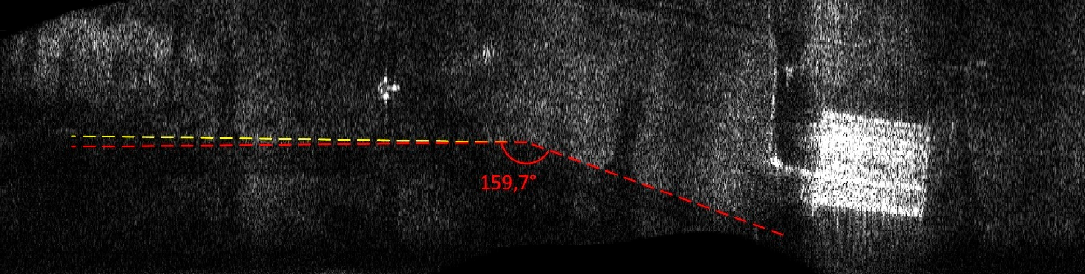
Figure 17. Radar terrain image obtained with the use of INS/GPS data; yellow line—a north edge of the taxiway determined using INS-based image, red line—a north edge of the taxiway determined using INS/GPS-based image.